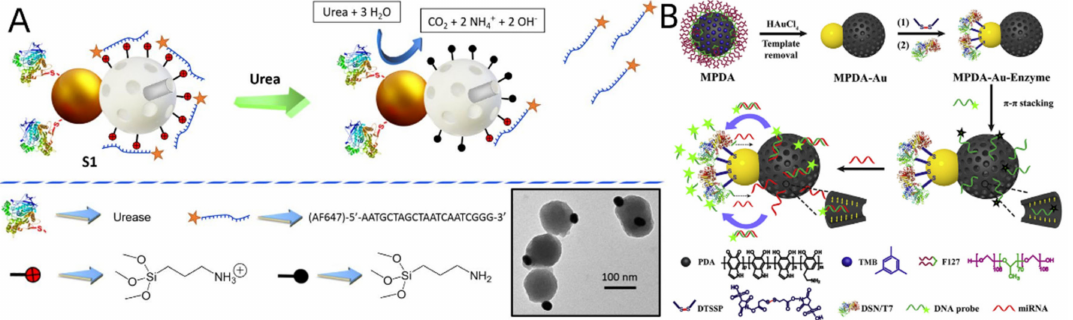
Figure 11. ( A ) Representation of the design and sensing performance of the nanosensor S1. Inset: TEM image of Janus Au–MSNPs. Reprinted with permission from ref. [184]. Copyright © 2019 Wiley– VCH. ( B ) Schematic illustration for the synthetic procedure and the miRNA detection application of Janus MPDA–Au nanoparticles. Reprinted with permission from ref. [185]. Copyright© 2020 Elsevier